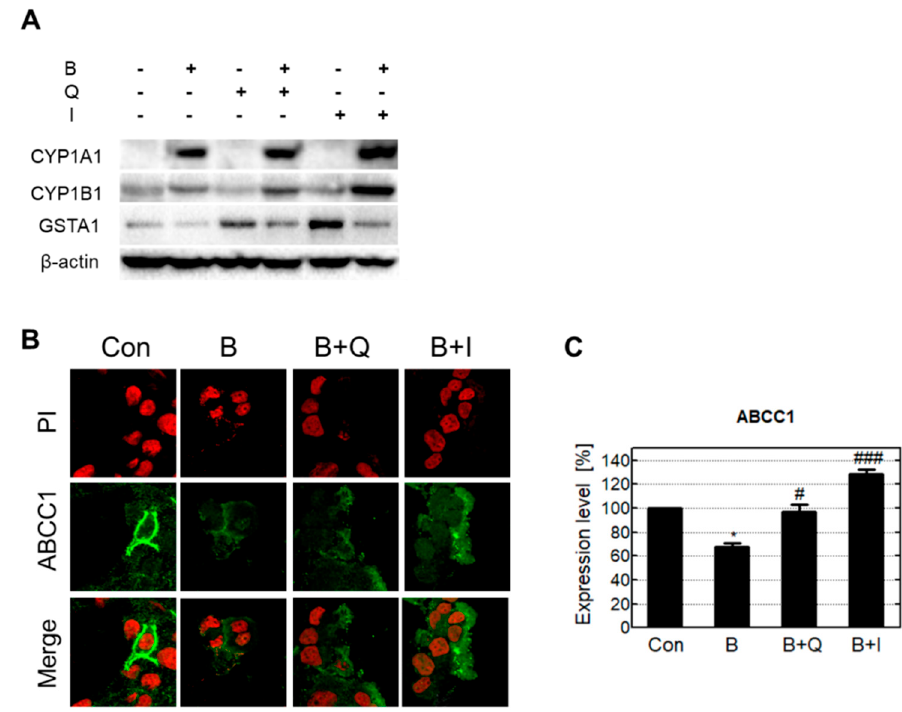
Figure 5. Increased protein expression levels of B[a]P metabolic enzymes induced by quercetin and isorhamnetin. ( A ) Analysis of intracellular protein levels of the phase I enzymes CYP1A1 and CYP1B1 and the phase II enzyme GSTA1. ( B ) Analysis of intramembrane protein levels of ABCC1. ( C ) Quantification and graphical presentation of ABCC1 expression levels. Con: control; B: benzo[a]pyrene (B[a]P) (10 µ M); Q: quercetin (5 µ M); I: isorhamnetin (5 µ M). * p < 0.05, # p < 0.01, ### p <